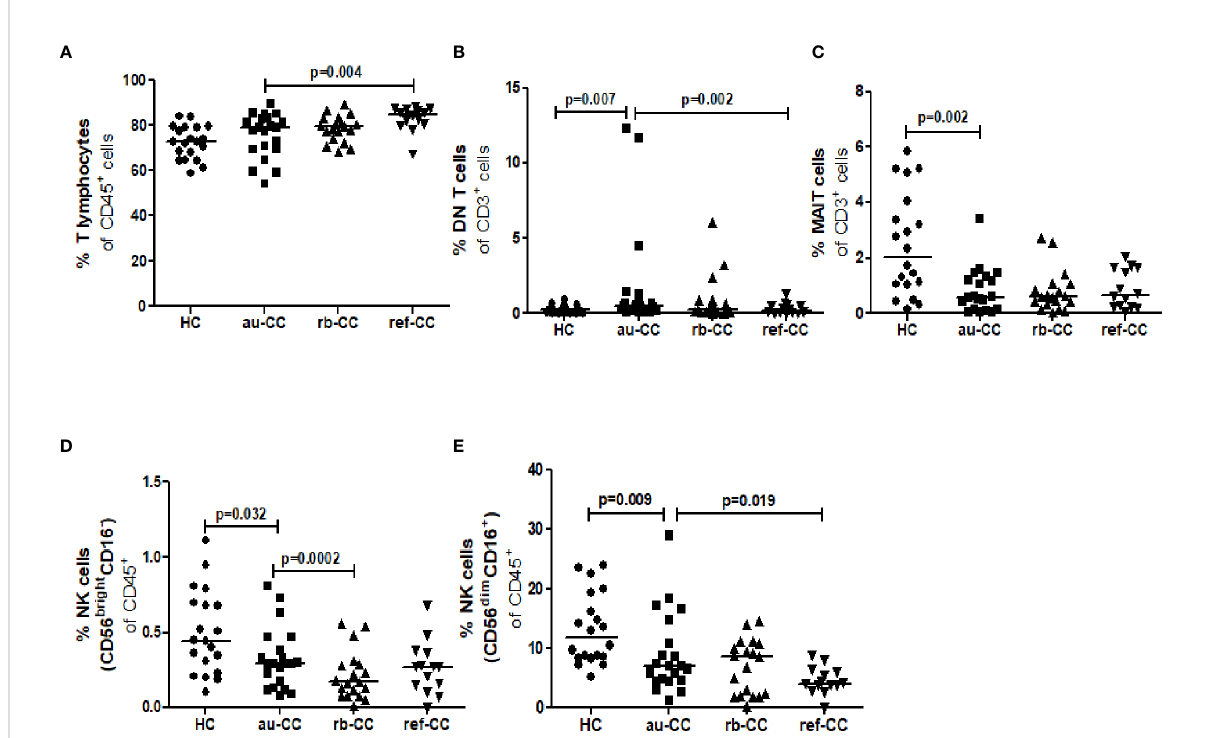
FIGURE 1 Cell population percentages of T lymphocytes (A) , DN T cells (B) , MAIT cells (C) , CD56brightCD16- NK cells (D) and CD56dimCD16+ NK cells (E) in the blood of CC patients. Analysis performed with fl ow cytometry. Statistically signi fi cant differences are p<0.01, statistical trends are p<0.05. au, active/untreated; CC, collagenous colitis; HC, healthy controls; rb,